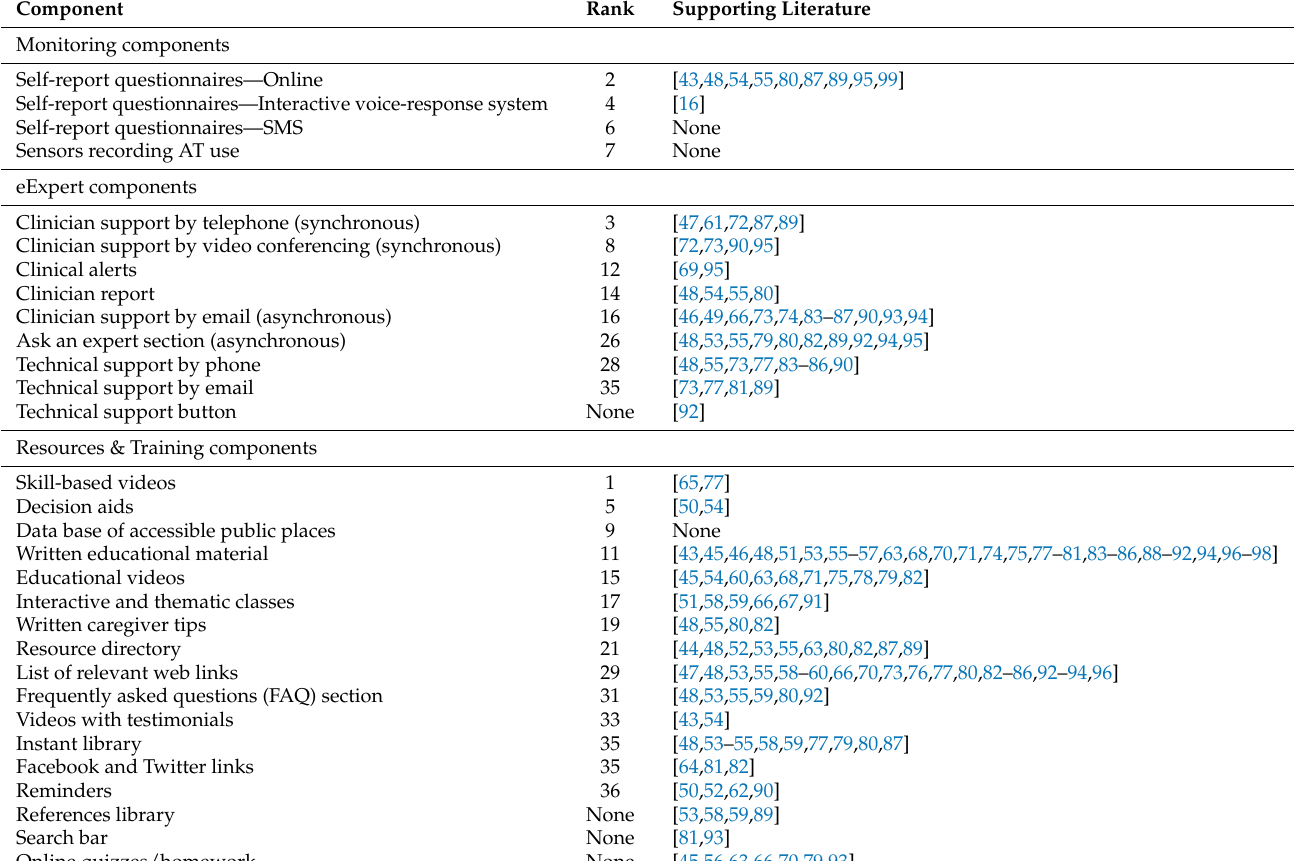
Table 2. Final list of retained components for